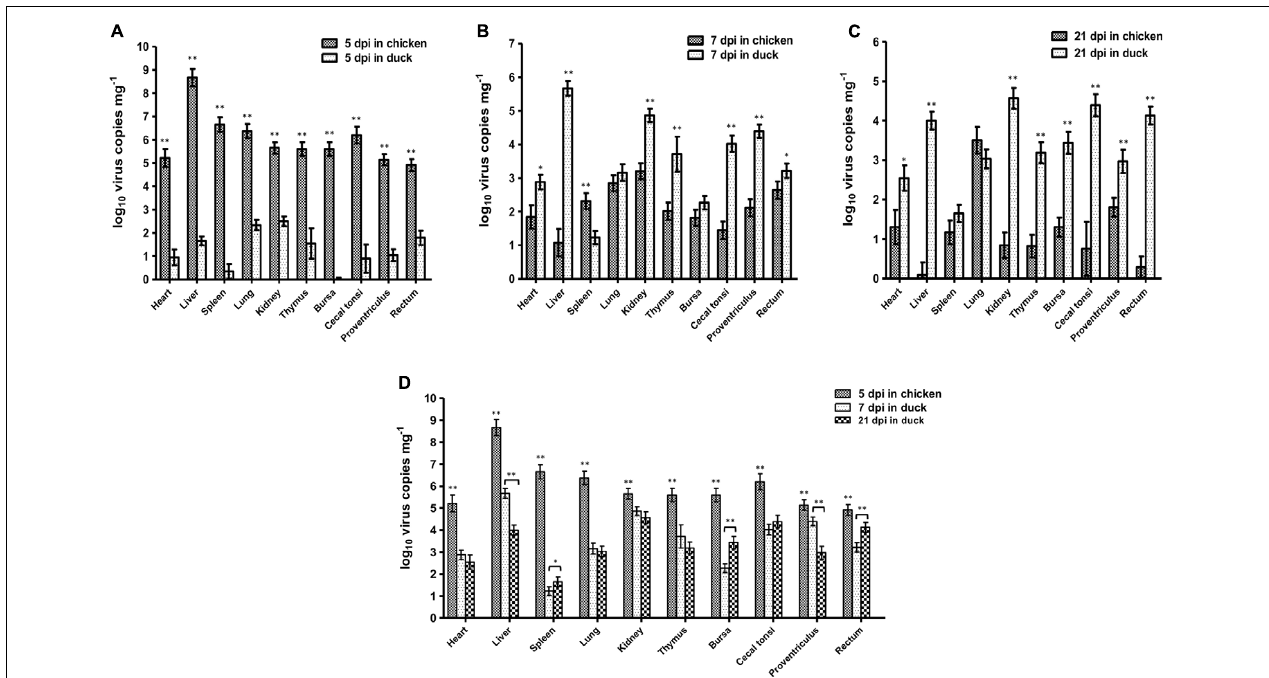
FIGURE 5 | Comparison of Virus Peak Concentration between Chickens and Ducks. The peak concentrations of duck origin FAdV-4 showed at 5 dpi in SPF chickens and 7 and 21 dpi in SPF ducks. The comparisons of virus titres between chickens and ducks at 5 dpi (A) , 7 dpi (B) , and 21 dpi (C) were separately analyzed. Furthermore, the highest virus titres in chickens at 5 dpi and in ducks at 7 and 21 dpi were compared (D) . The peak concentrations of FAdV-4 in all tissues of chickens were significantly higher ( ∗∗ p < 0.01) than those in ducks. The highest concentration was in the livers of chickens ( ∗∗ p < 0.01), whereas the lowest concentration of virus copies appeared in the spleens of ducks ( ∗∗ p < 0.01).